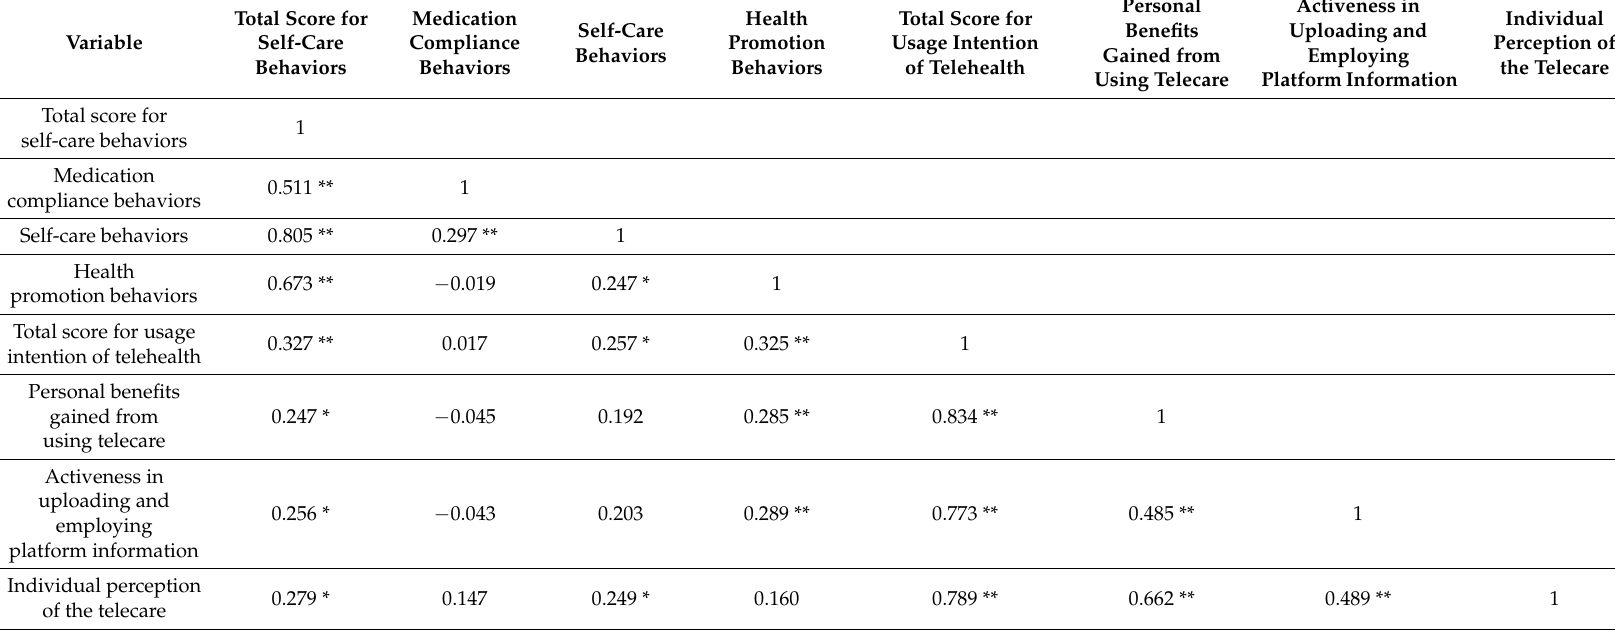
Table 3. Correlation between the self-care behaviors of the participants and their IUT (N = 82) via Pearson’s correlation coefficient. Variable